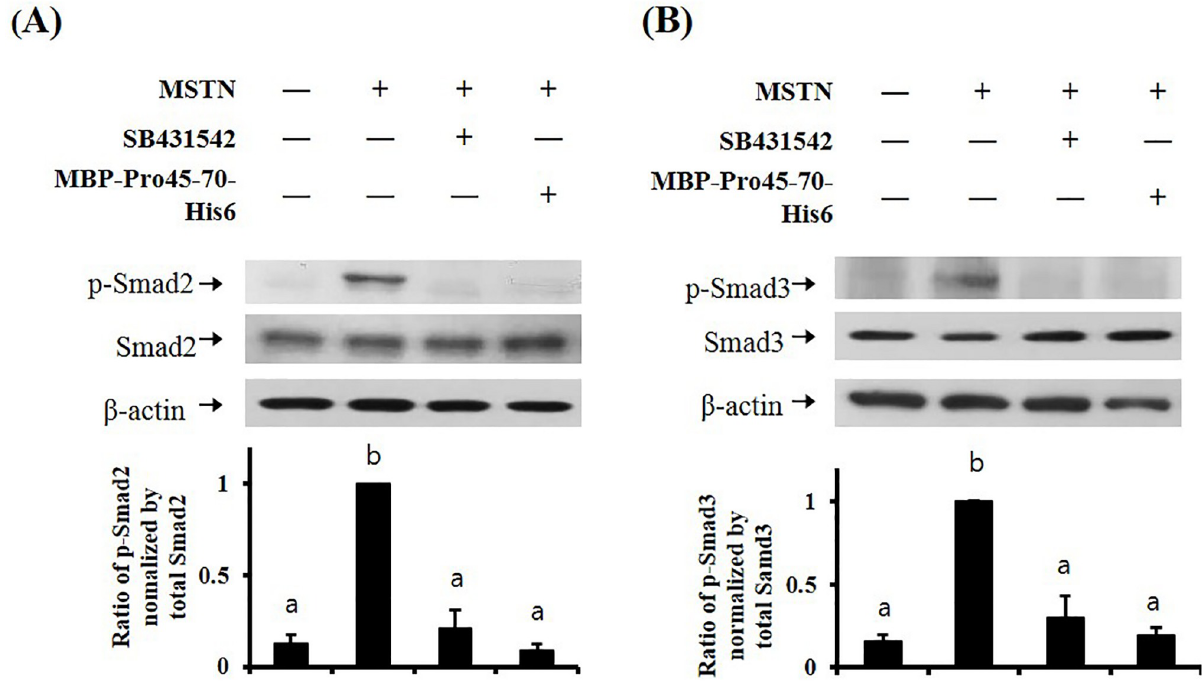
Fig 2. MBP-Pro45-70-His6 blocks MSTN-induced Smad2/3 phosphorylation in HepG2 cell. HepG2 cells were cultured in serum-free DMEM for 4 h, followed by treatment with the combination of 10 nM MSTN, 10 μ M SB431542, or 600 nM MBP-Pro45-70-His6 for 30 min. The blots are representative of three independent assays and have been sequentially probed with antibodies against phospho-Smad2 (p-Smad2) or phospho-Smad3 (p-Smad3), total Smad2 (Smad2) or total Smad3 (Smad3), and b-actin. Densitometry analyses of the blots were from three independent assays. The Relative phosphorylation levels of p-Smad2 and p-Smad3 were normalized by the expression level of total Smad2 (A) or total Smad3 (B), respectively. The error bars indicate standard deviation (n = 3). Different letters are significantly different at P < 0.05.